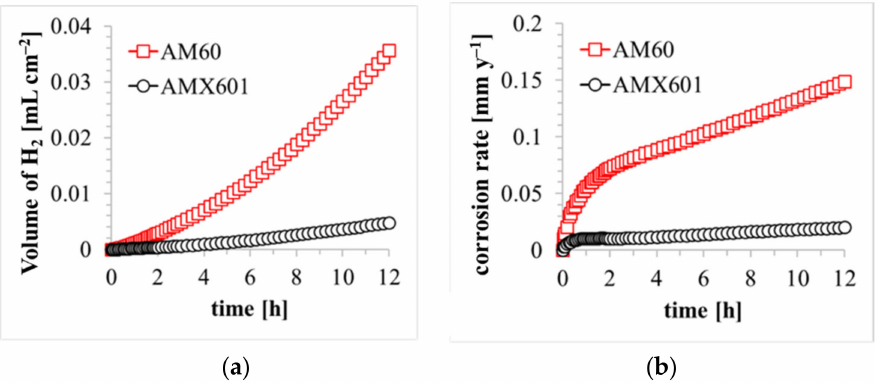
Figure 8. ( a ) Hydrogen evolution rate curve; ( b ) corrosion rate curves for AM60 and AMX601 alloys immersed in NaOH solution (pH ≈ 10.5) at room temperature.